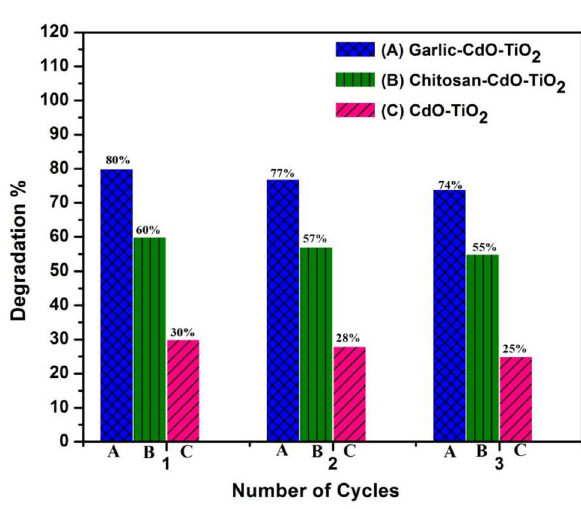
Figure 10. Recyclability of the synthesized